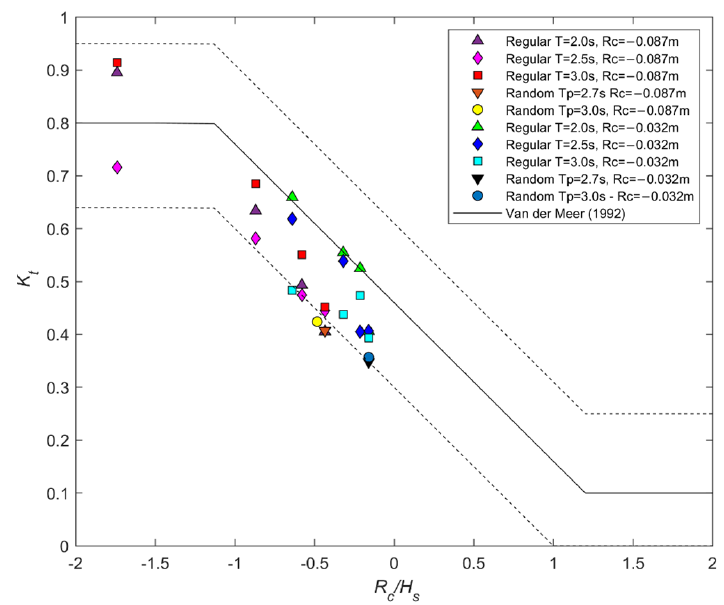
Figure 13. Wave transmission coefficients vs. nondimensional submergence for both regular and random waves. Trend line [8]. Regular waves with periods: T = 2.0 s (upward triangle), T = 2.5 s (diamond) and T = 3.0 s (square). Random waves with peak periods T p = 2.7 s (downward triangle) and T p = 3.0 s (circle). Submergence R c = − 0.087 m (hot colors) and R c = − 0.032 m (cold colors).